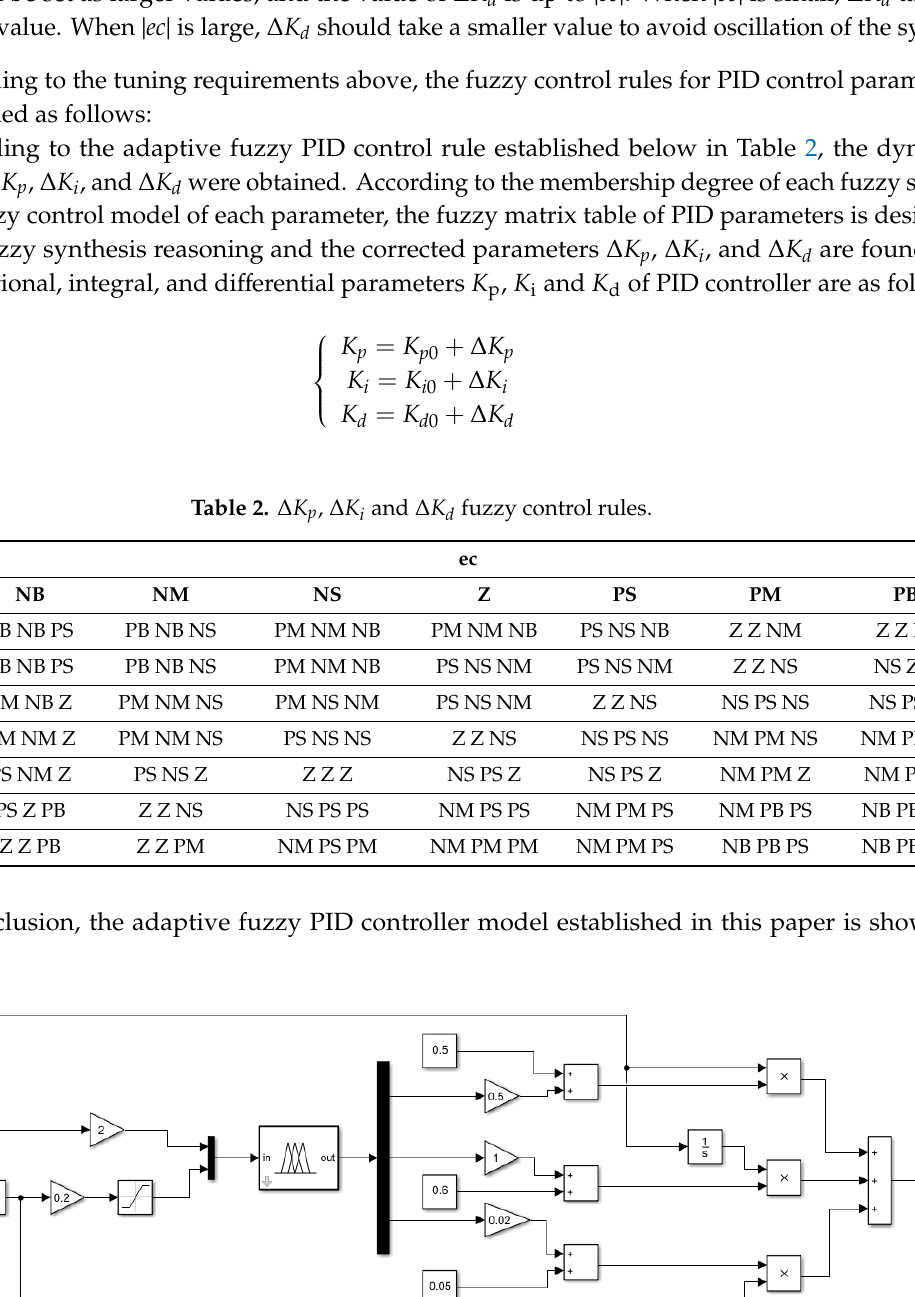
Table 2. ∆ K p , Δ K i and ∆ K d fuzzy control rules.